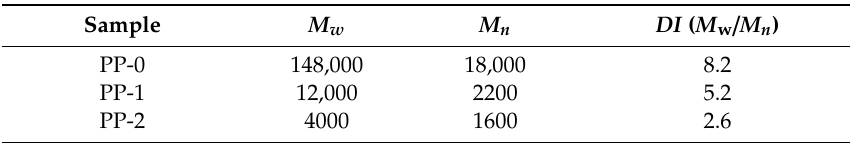
Table 2. The weight average molar mass ( M w ), number average molar mass ( M n ) and dispersity index ( DI ) of the PP-0 to 2 samples used in this